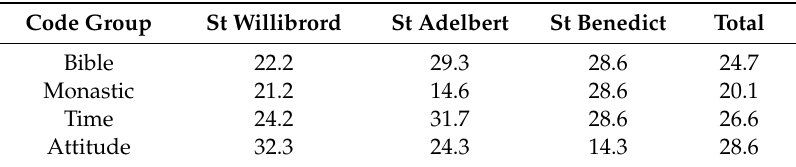
Table 7. Dimensions of reading—monastic context. Code Group